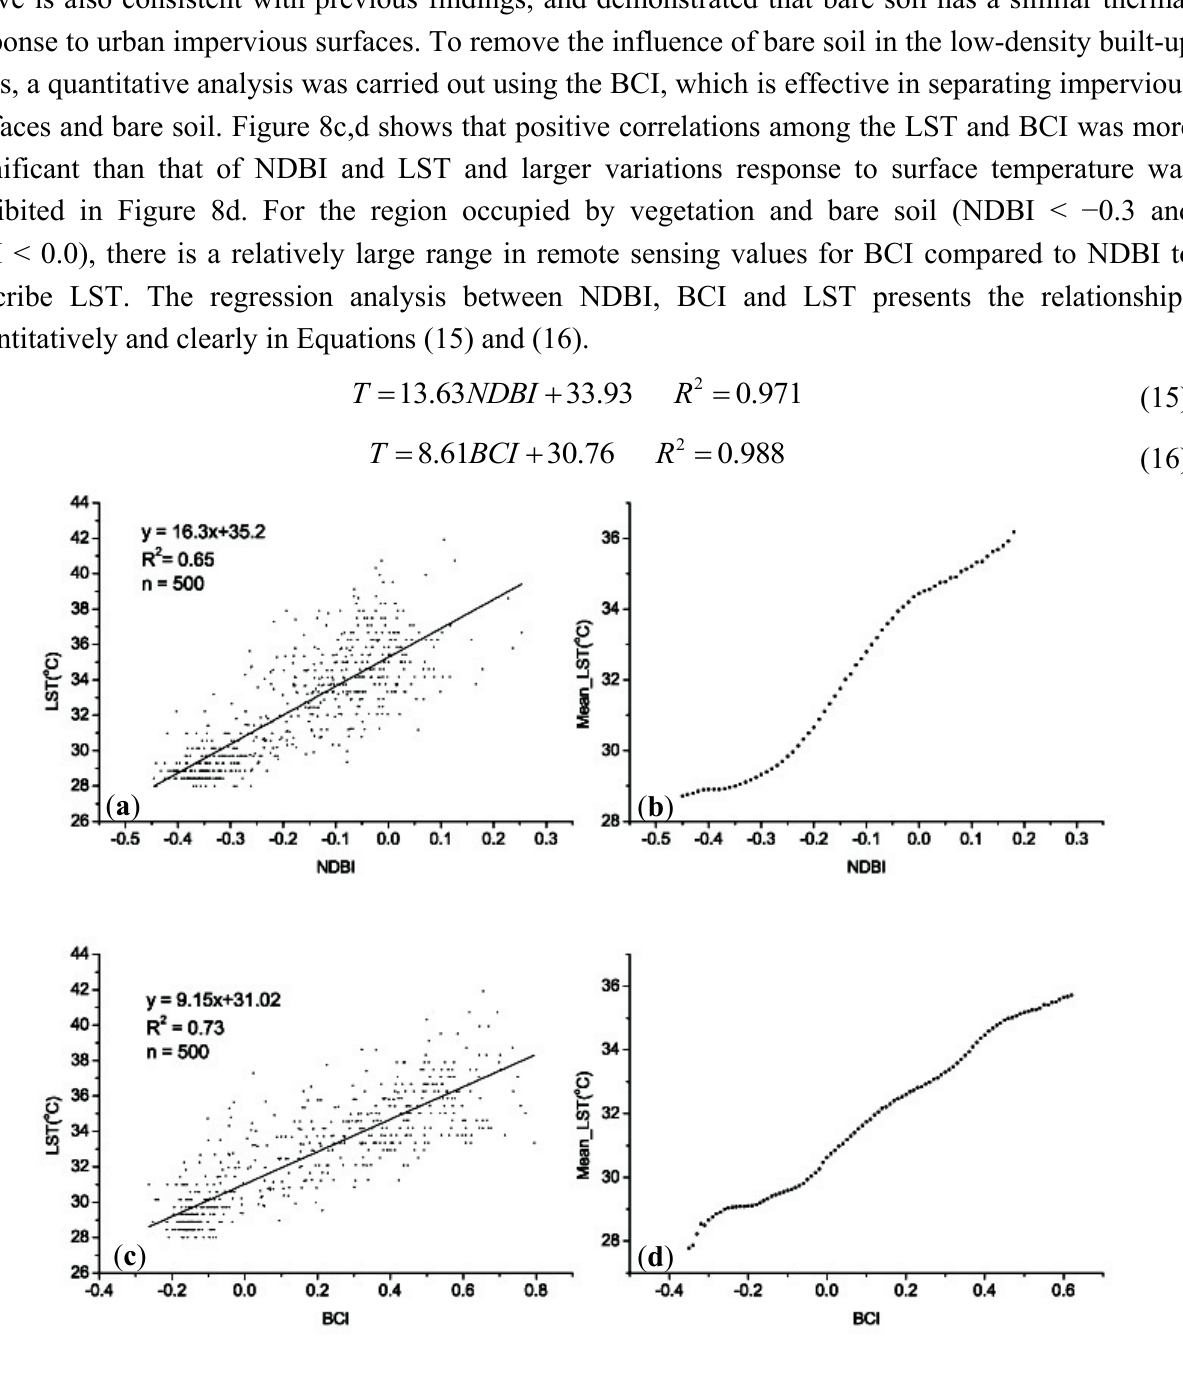
Figure 8. Scatterplot of LST vs. remote sensing indexes on 15 August 2010 (a) Scatterplot of LST vs. NDBI; ( b ) Scatterplot of mean LST vs. NDBI; ( c ) Scatterplot of LST vs. BCI; and ( d ) Scatterplot of mean LST vs.